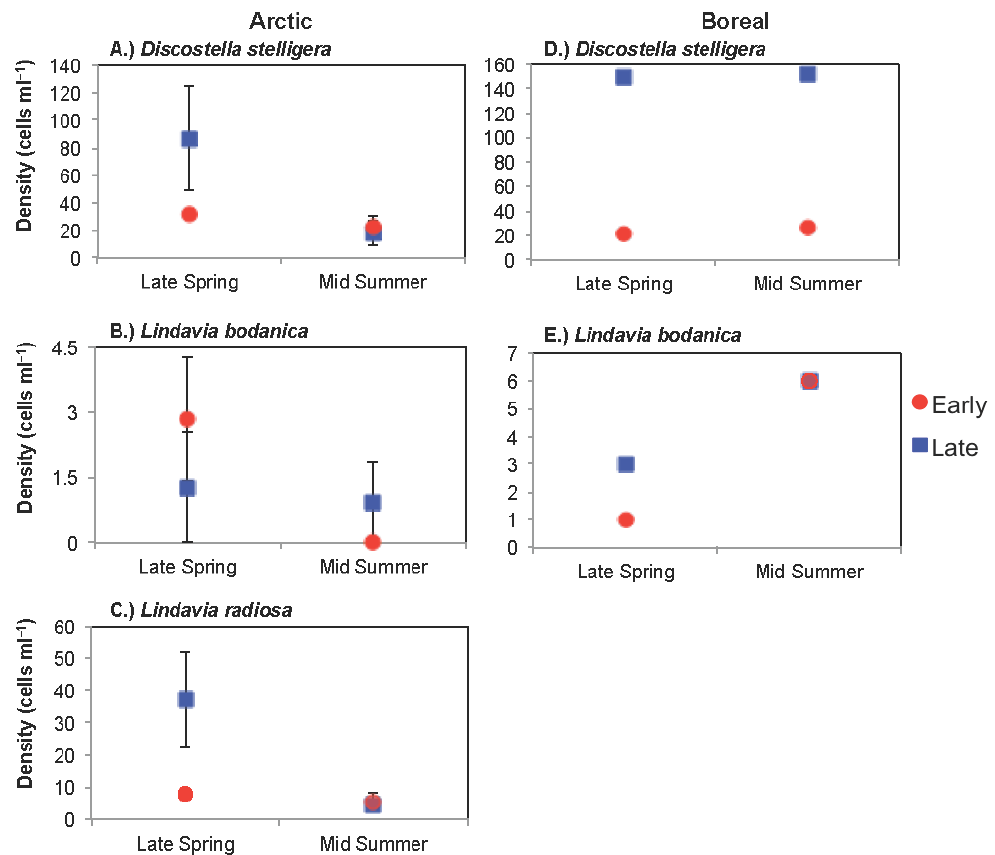
Figure 5. Comparison of ( A ) Discostella stelligera ; ( B ) Lindavia bodanica ; and ( C ) Lindavia radiosa in Arctic lakes and ( D ) Discostella stelligera and ( E ) Lindavia bodanica in a boreal lake for early and late ice-out years. Phytoplankton collection occurred at the time of sampling for all lake metrics for spring and summer and early and late ice-out years. Responses of the three Arctic lakes are averaged (mean ± standard error) on each date. Purple points indicate overlapping results for early and late ice-out years.